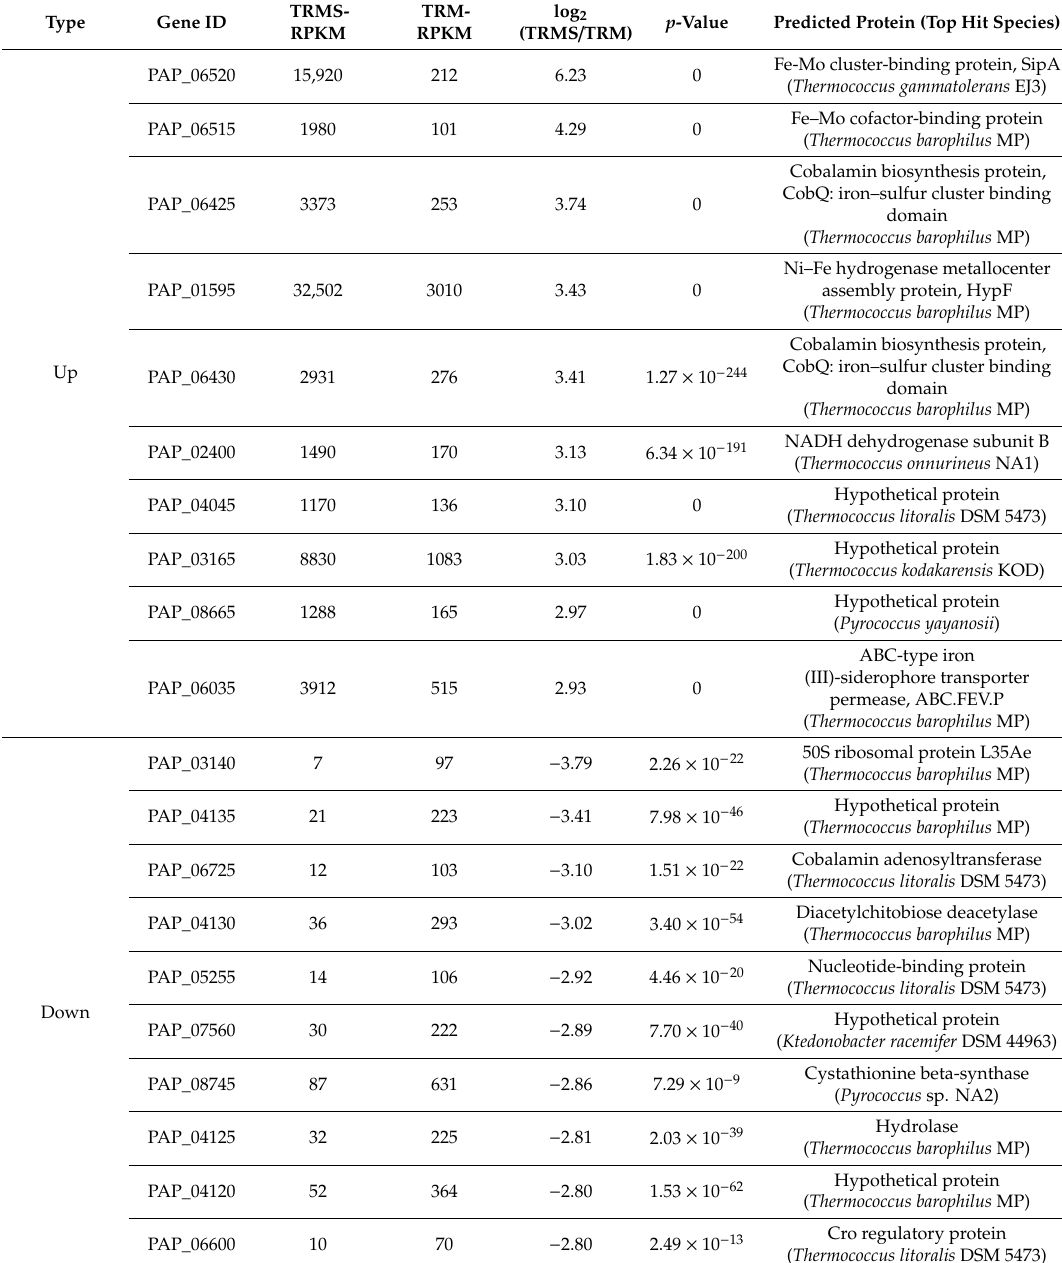
Table 1. Top 10 upregulated or downregulated genes in Pa. pacificus grown with S 0 (TRMS) compared to without it